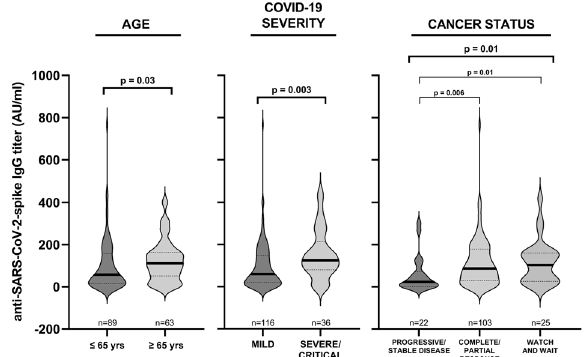
Fig. 1 Association of anti-SARS-CoV-2-spike IgG titer with age, COVID-19 severity, and cancer status. Violin plots depicting anti-s IgG titers, measured within 6 months from the fi rst positive SARS- CoV-2 PCR, in hematologic malignancy (HM) patients grouped according to age, COVID-19 severity, and cancer status. Bars represent median (thick line) and interquartile range (dotted line). Statistical analysis was performed by Kruskal – Wallis and Dunn ’ s tests.